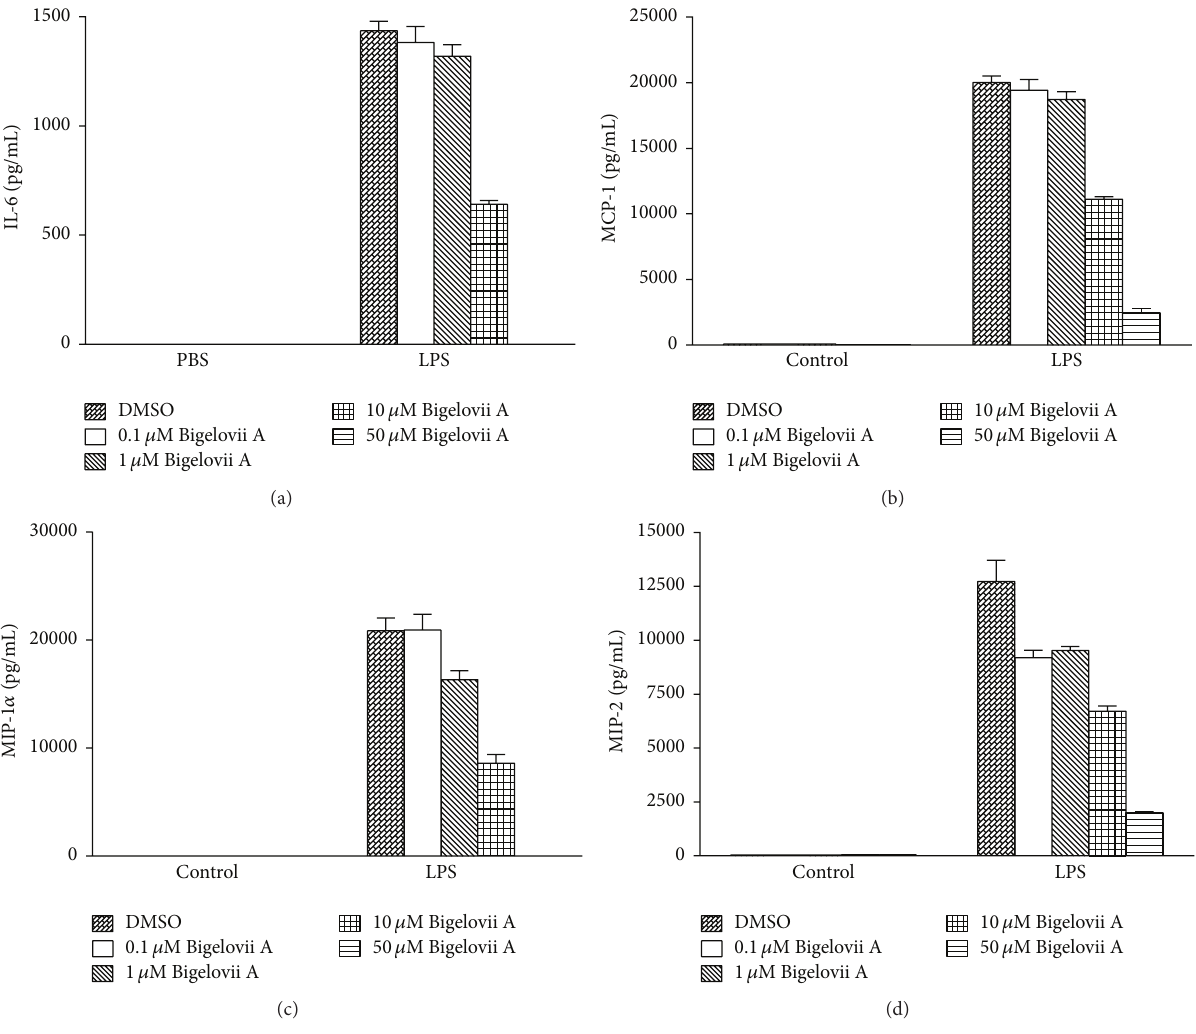
Figure 4: Effect of Bigelovii A on cytokine and chemokine secretion during LPS-induced inflammation in MH-S cells. MH-S cells were pretreated with the indicated dose of Bigelovii A for 1h, followed by treatment with PBS or 100ng/mL of LPS for 6h. Then cell-free supernatants were harvested, and ELISA was conducted to measure production of IL-6 (a), MCP-1 (b), MIP-1 𝛼 (c), and MIP-2 (d). Results are reflected by means ± SEM ( 𝑛 = 6